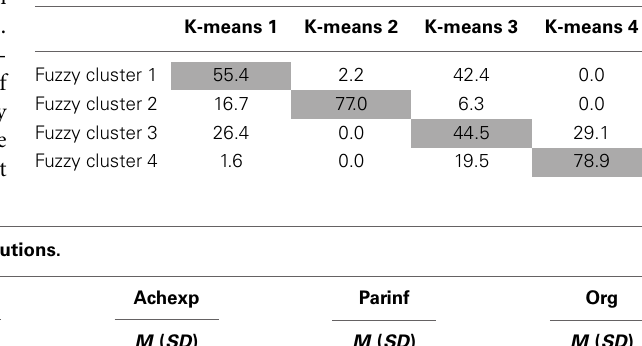
Table 3 | Percentage of fuzzy cluster solutions that belong to corresponding k-means clustering solutions with a membership exponent of 2.0.